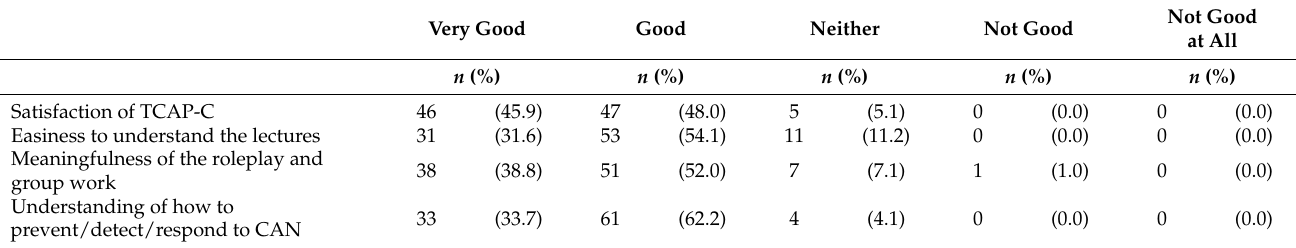
Table 3. Acceptability of TCAP-C ( n =